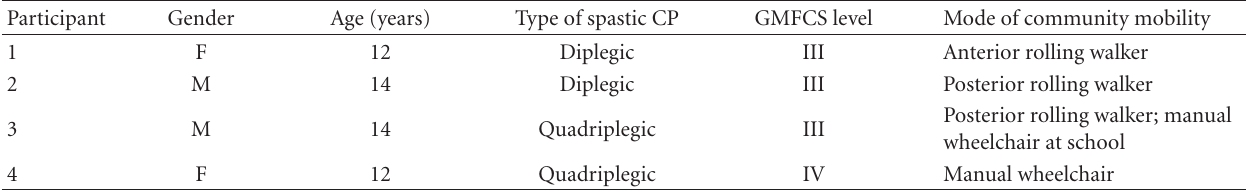
Table 2: Participant description and FES parameters for cycling tests with